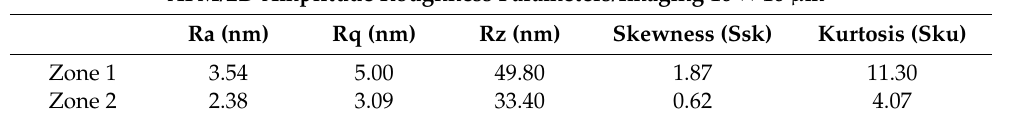
Table 8. 2D Roughness parameters were calculated from the 10 × 10 µ m 2 field of view images obtained by AFM of zone 1 and 2.